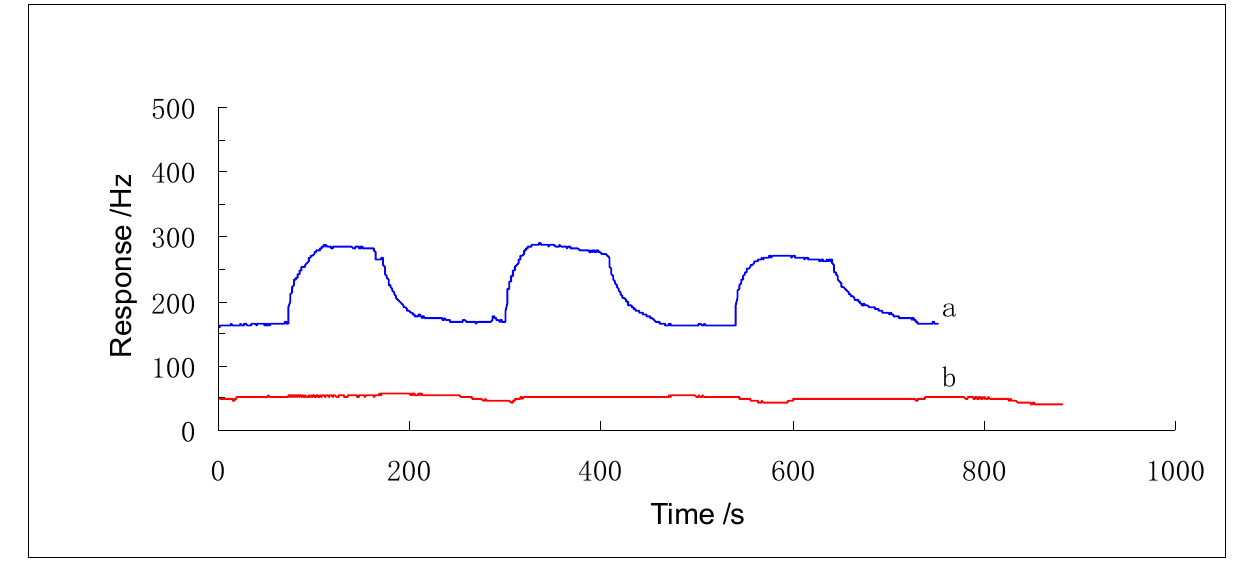
Figure 3. The reversible response curve to 4 ppm DMMP: ( a ) Hollow ball; ( b ) Solid